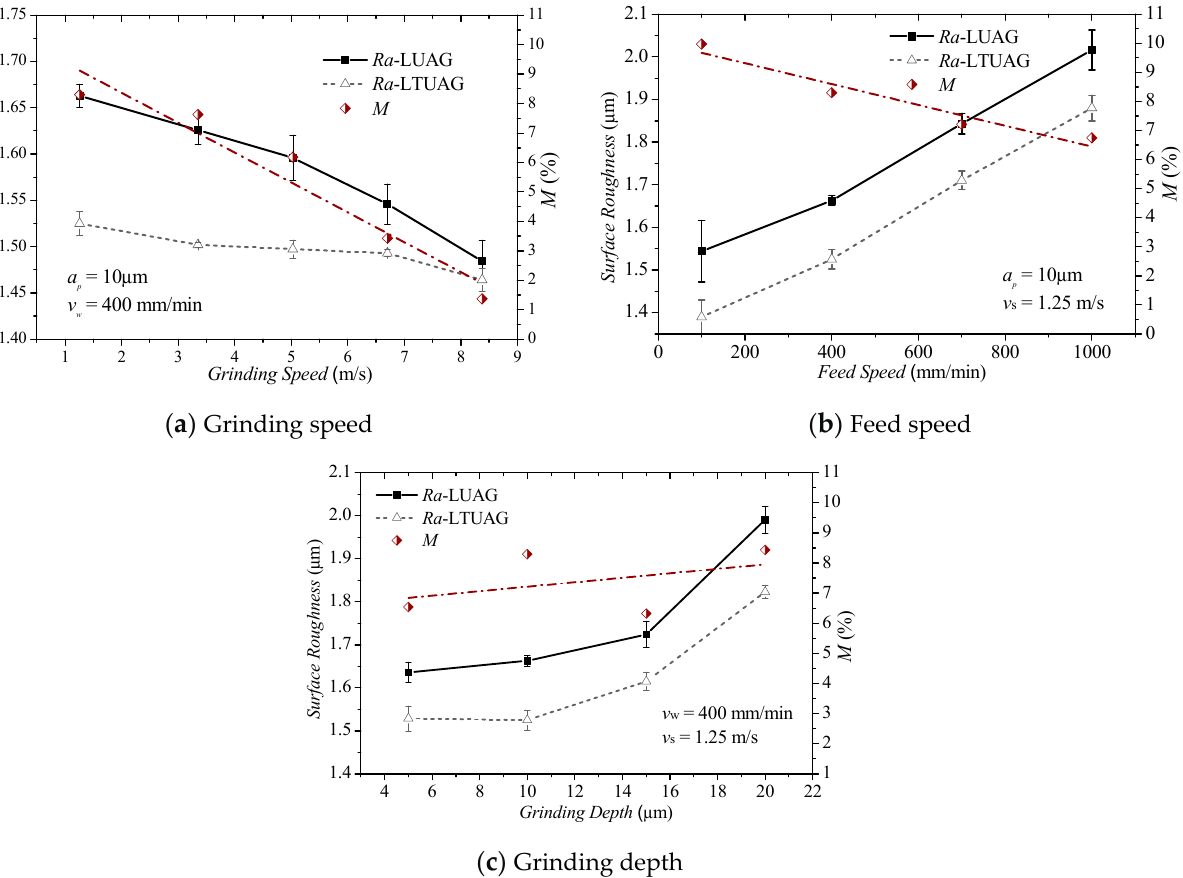
Figure 16. Effect of grinding parameters on surface roughness ( M is the reduction rate of the surface roughness produced by LTUAG compared to the surface roughness produced by LUAG, M = ( Ra LUAG − Ra LTUAG ) × 100%/ Ra LUAG ).